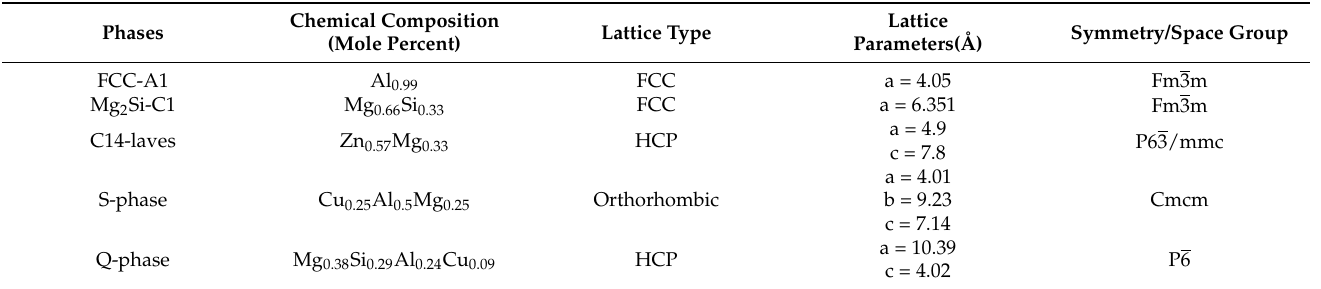
Figure 2. Equilibrium phase diagram of function of Zn content. Arrows represent the areas of thermodynamic stability for various phases. Table 3. Crystallographic parameters of phases provided by Thermocalc®software and literature [34,